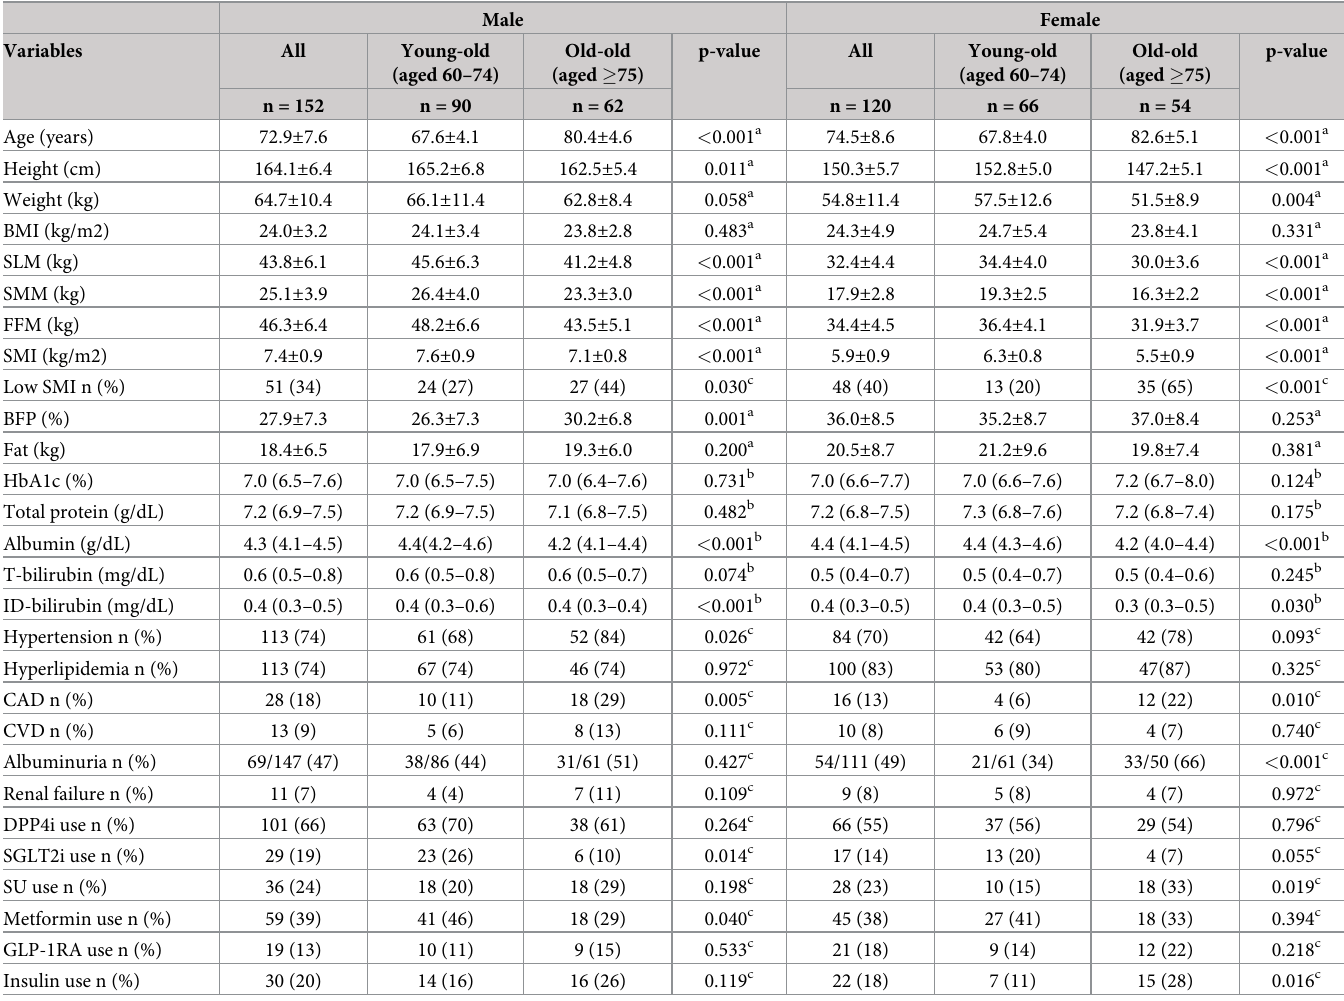
Table 1. Clinical characteristics of